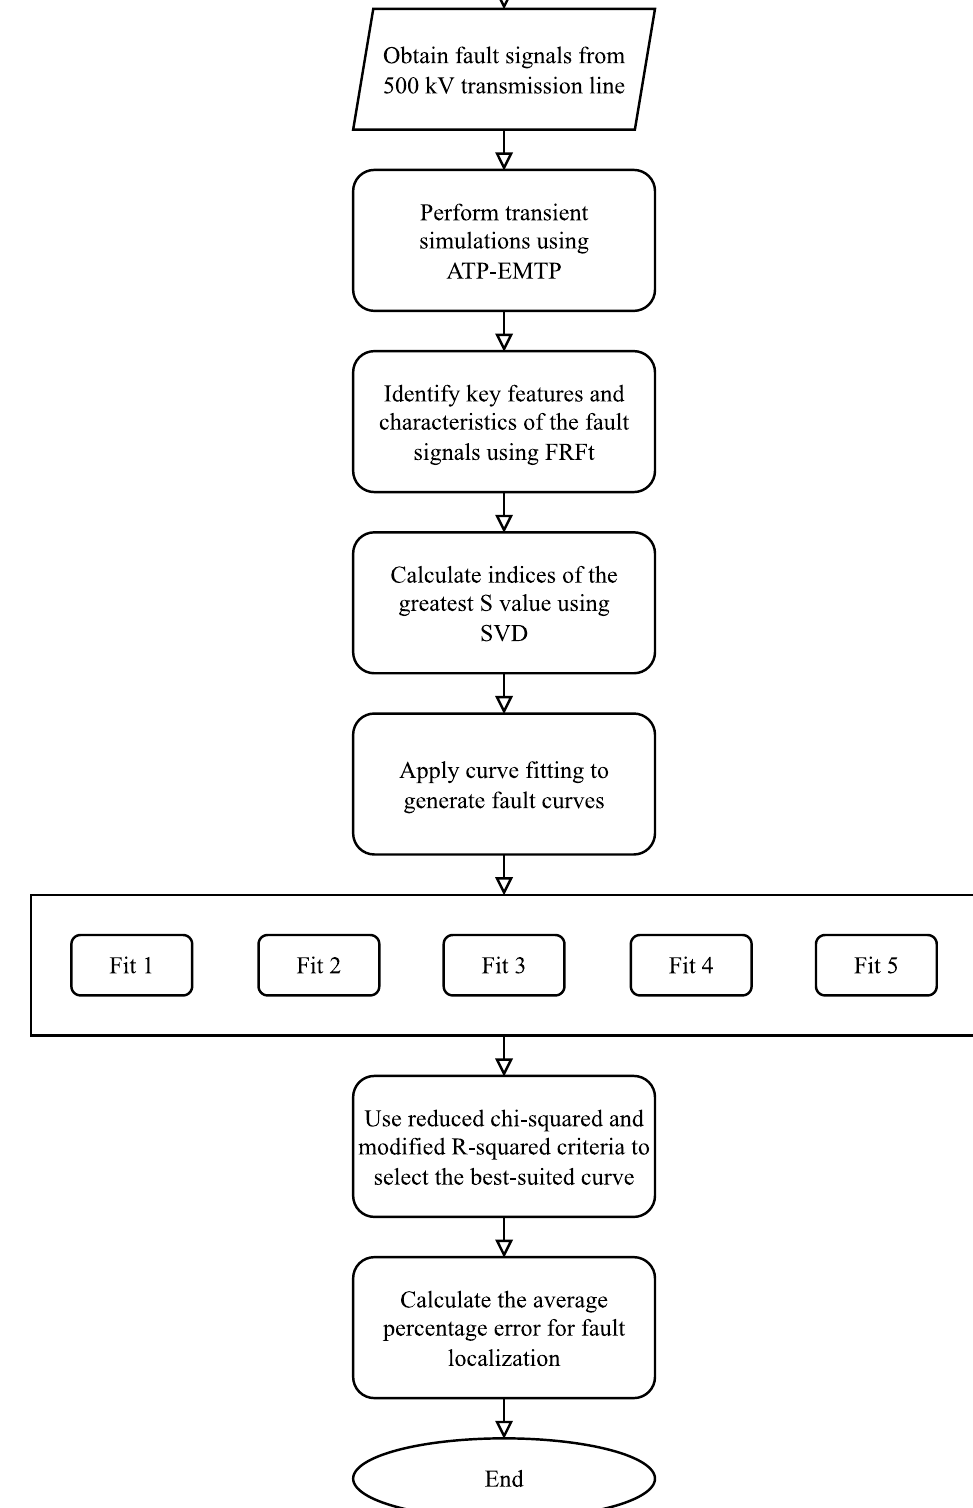
Figure 5. The block diagram for the proposed method.